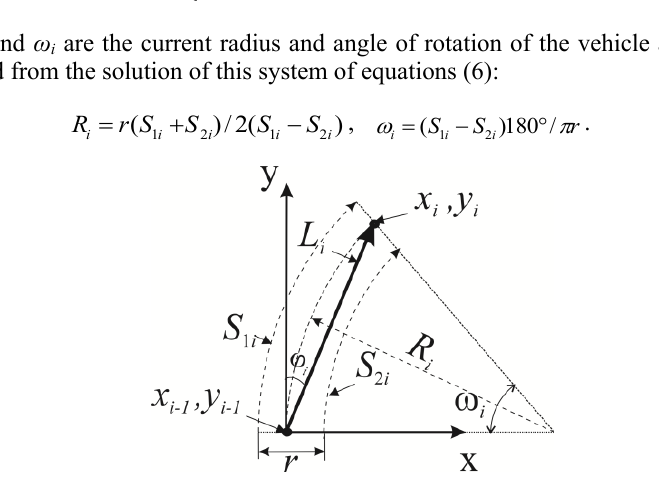
Fig. 2. Determination of the displacement vector L i when the vehicle is